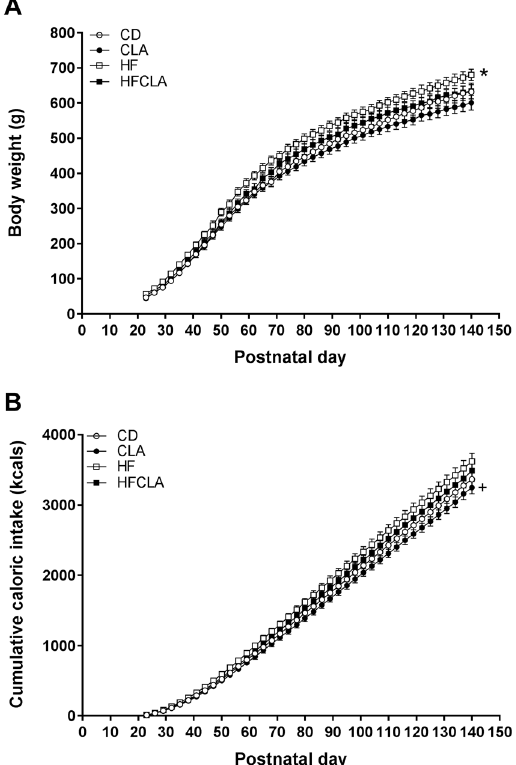
Figure 1. Postnatal growth curve and caloric intake. ( A ) Body weights and ( B) cumulative caloric intake of male offspring post-weaning. Data analysed by two-way repeated measures ANOVA, with maternal diet and time as factors. Post-hoc Holm-Sidak analysis was performed. Data expressed as means ± SEM ( n = 5–6 litters/ group), where * P < 0.05 vs CD and CLA, and + P < 0.05 vs